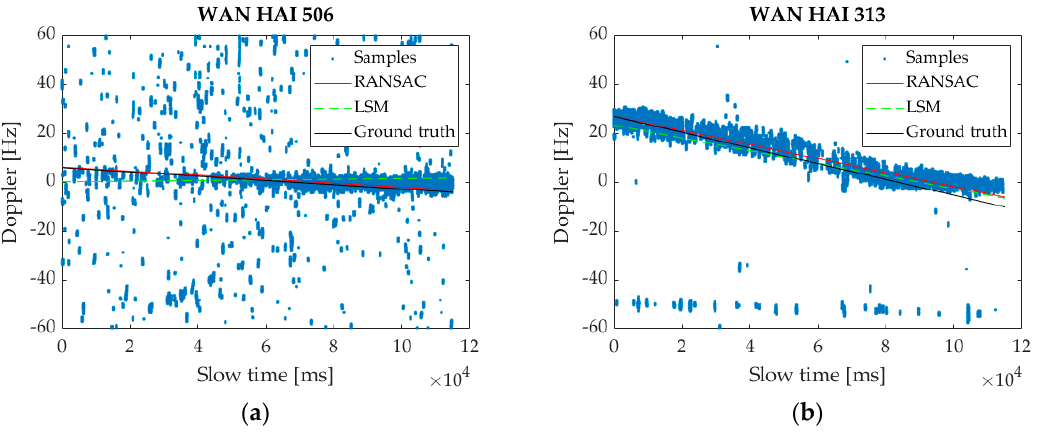
Figure 13. Fitting results: ( a ) is WAN HAI 506, and ( b ) is WAN HAI 313.